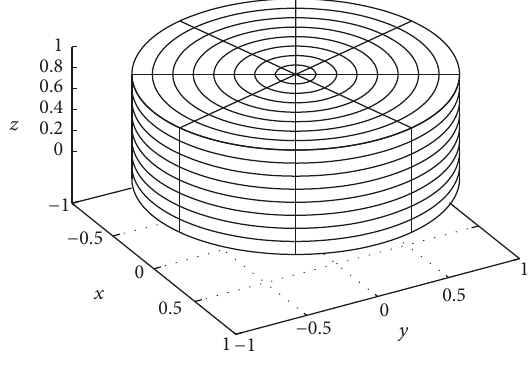
Figure 12: Cylindrical